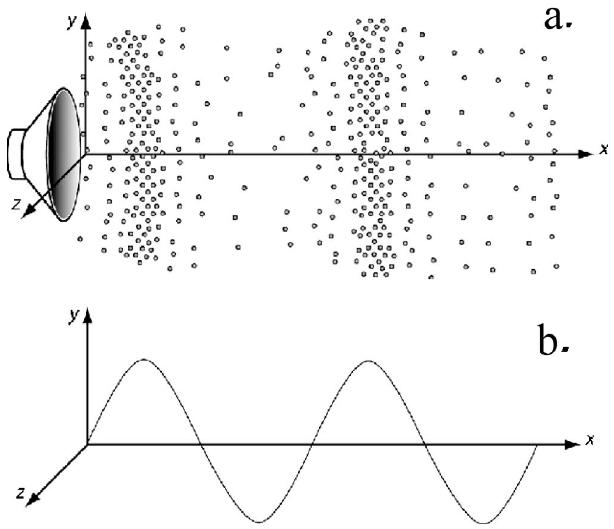
FIG. 1. A sound wave represented by a picture of compressed and rarefied air particles (cid:1) a (cid:2) and a sine wave (cid:1) b (cid:2)